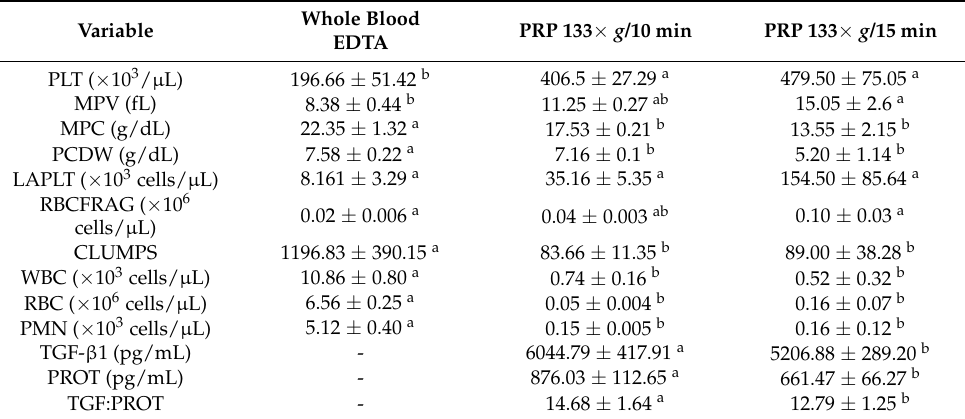
Table 1. Plasma components of whole-blood samples (EDTA) and PRP (ACD) obtained by centrifu- gation at 133 × g for 10 and 15